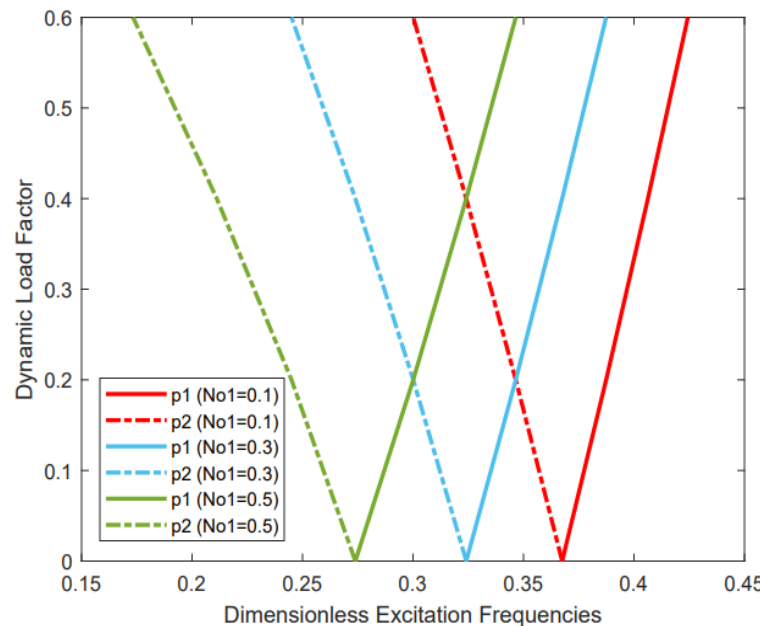
Figure 6. The effect of static load.